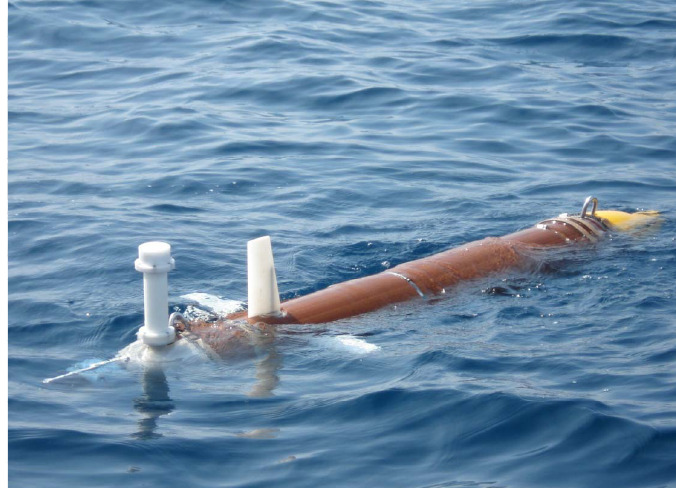
Figure 4. The MAYA Autonomous underwater vehicle developed at NIO,